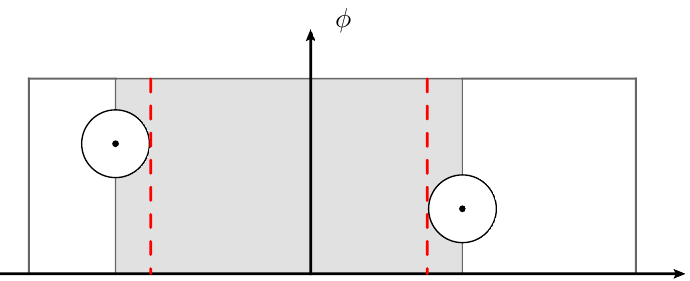
Figure 4 . De(cid:12)nition of the gap region for a dijet system in the rapidity and azimuthal plane, as used by ATLAS [14]. If a jet with transverse momentum larger than Q 0 is radiated into the gray region, the event is vetoed. The two dashed red lines indicate the boundary of the approximated veto region used in